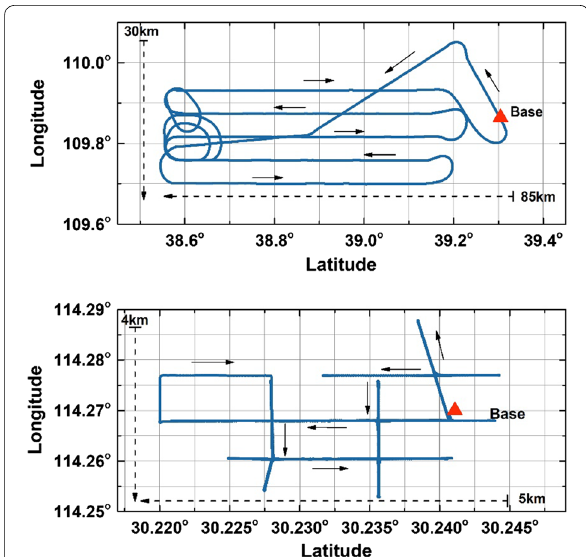
Fig. 3 The trajectory of the rover (blue) and the base station (red triangle) in measuring area in the airborne experiment (top) and the vehicular experiment (bottom)